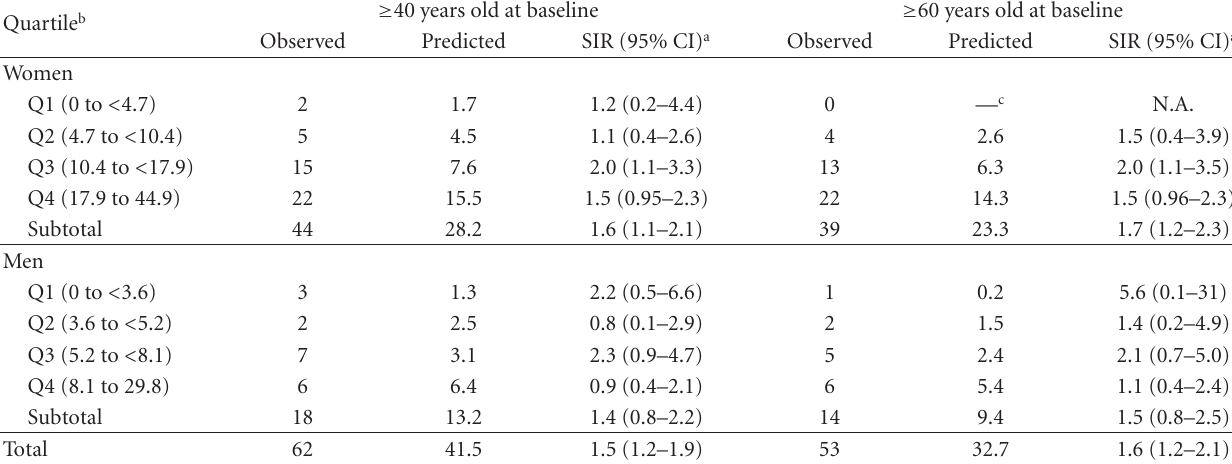
Table 3: First major osteoporotic fractures observed among Rochester, MN women and men compared to numbers predicted by revised US FRAX (FN BMD), by age at baseline and quartile of full 10-year fracture probability (%). Quartile